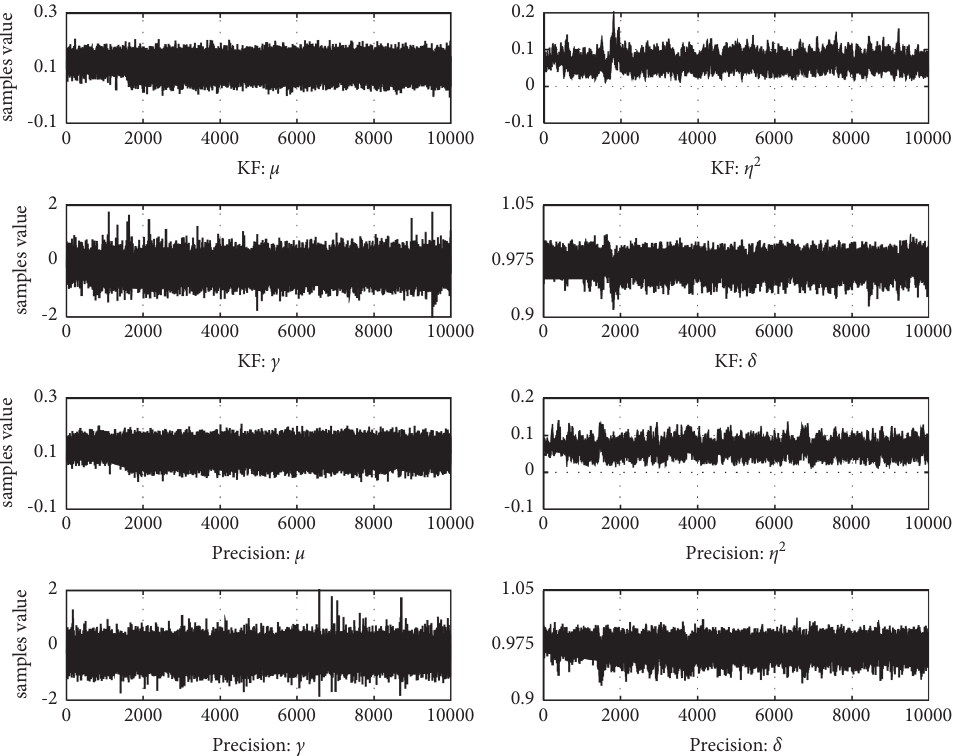
Figure 4: The sample paths of the parameters in the SV model.